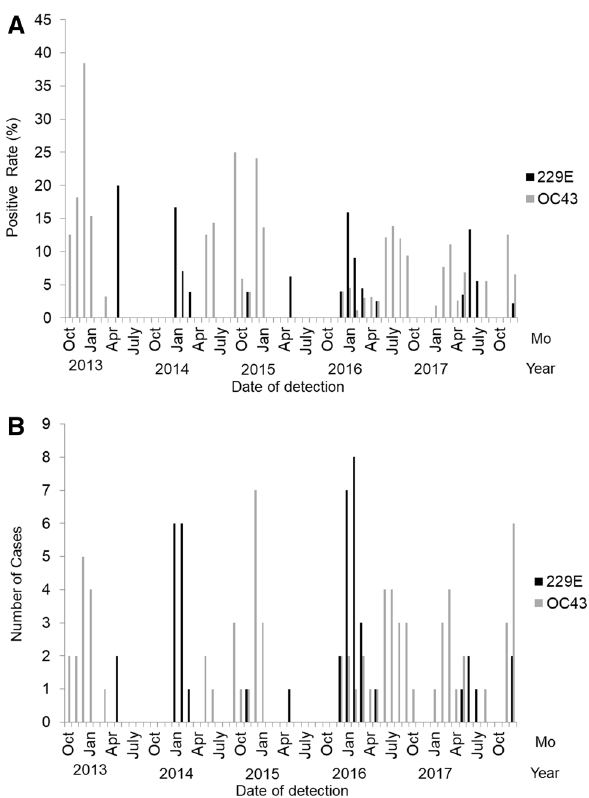
Figure 2. Human coronaviruses (HCoV 229E, black bar and HCoV OC43, gray bar) detected rate ( A ) among virus-infected adult patients and the number of infection ( B ) in each month, October 2012 to December